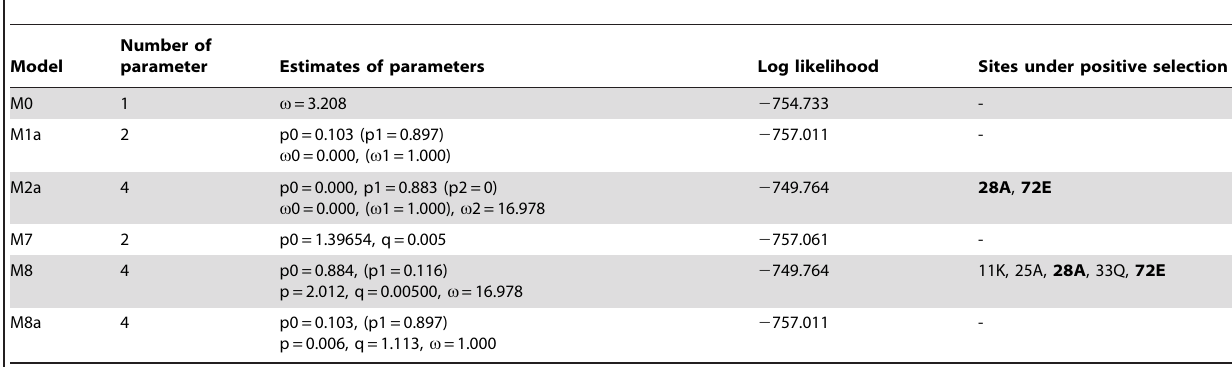
Table 3. Log-likelihood values and the estimates of parameters under models with variable v ratios in three coral CEL-III genes.